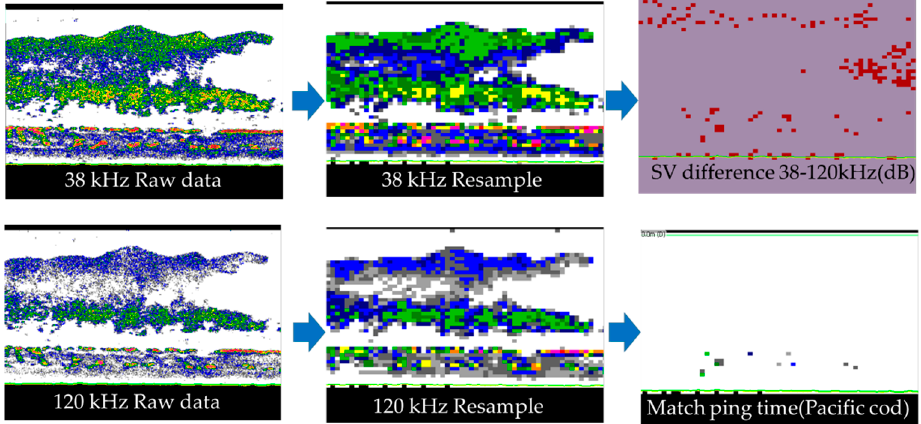
Figure 3. Pacific cod identification example.